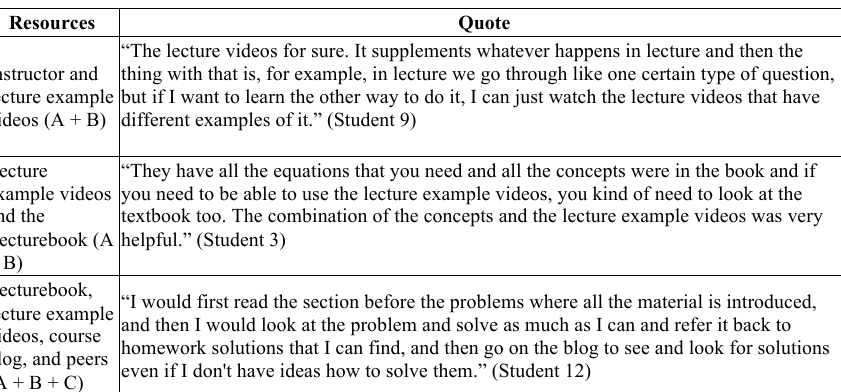
Common learning resource integration strategies. The specific ABC components are listed in